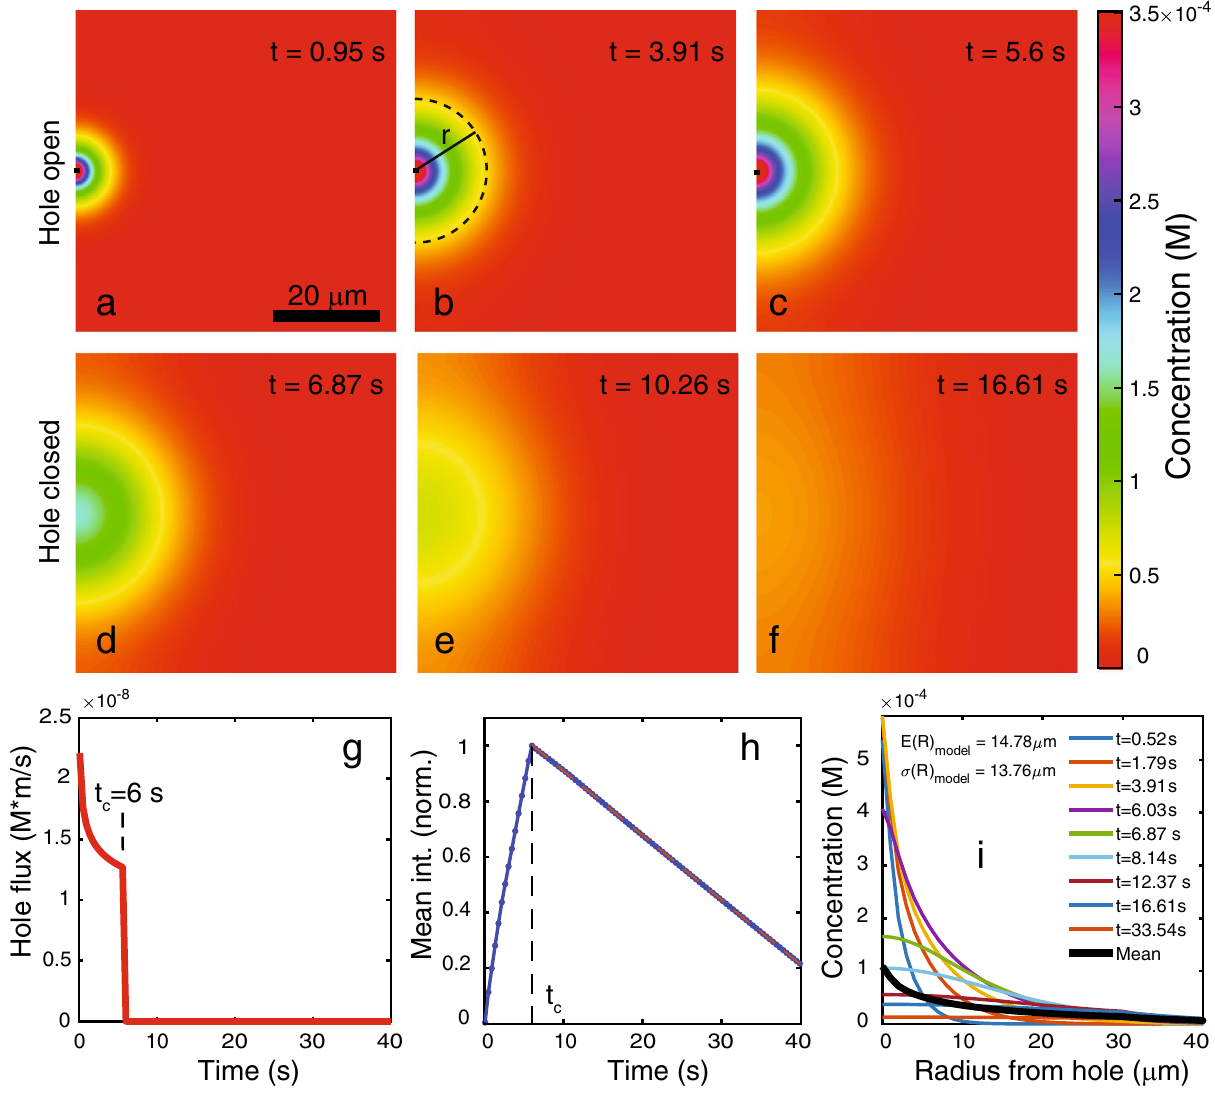
Figure 5. Output from model of the intracellular calcium distribution. Spatial distribution of the calcium concentration (unit = M) at selected time points before and after hole closure at time t c = 6 s ( a – f ). Diffusion 1 µ m , initial extracellular calcium conc. c o 2.7 10 − 11 m 2 / s , hole width w h coefficient D = = · 100 nM, pump rate K 5 10 − 7 m / s . Time dependence of the hole flux J x intracellular calcium conc. c i = = · as determined from the solution to the 2-box model in figure 1b ( g ). Mean concentration inside simulation box normalized to the peak maximum ( h ). Radial distribution of the calcium concentration relative to the membrane hole at selected time points ( i